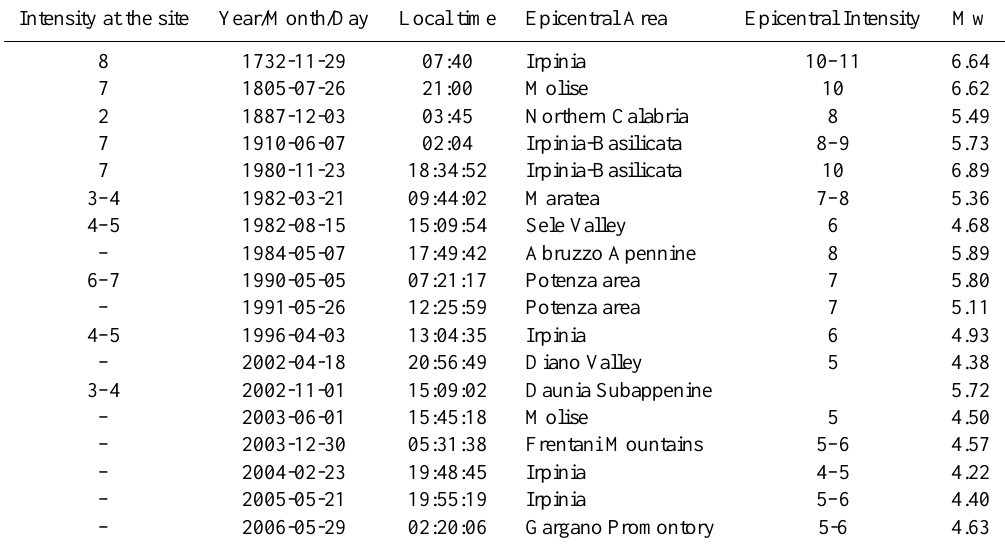
Table 3. Historical seismicity affecting Castelfranci (after DBMI11, by Locati et al., 2011). Intensity at the